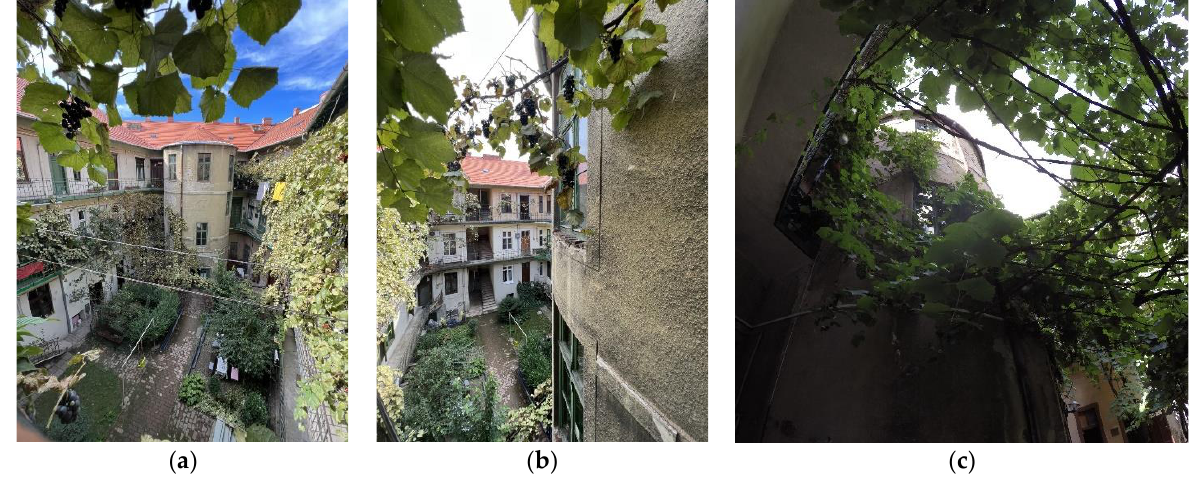
Figure 8. Interior courtyard of the Lajos (Ludwig) Besch and Károly (Karl) Piffl Palace ( a ) Right top view; ( b ) Left top view; ( c ) Bottom view.